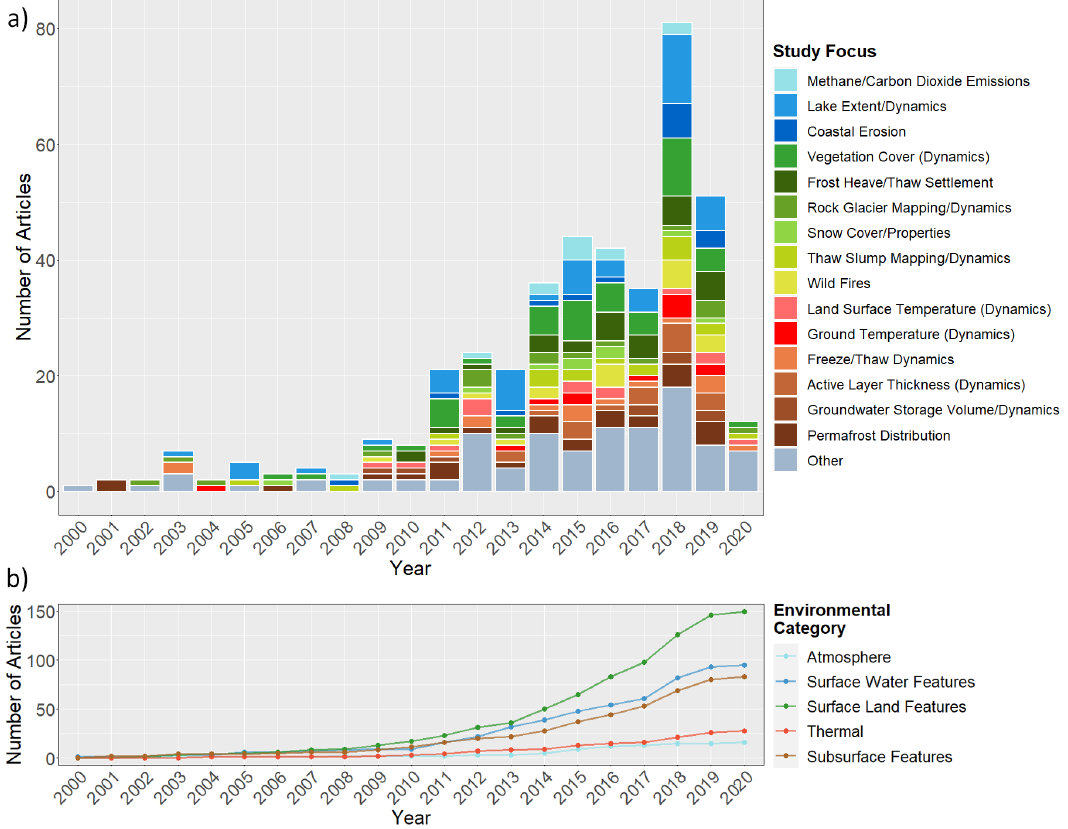
Figure 8. ( a ) Frequency of the top 15 most common and permafrost related environmental foci across the reviewed articles per year. Several articles covered multiple environmental foci. ( b ) The cumulative sum of articles per environmental